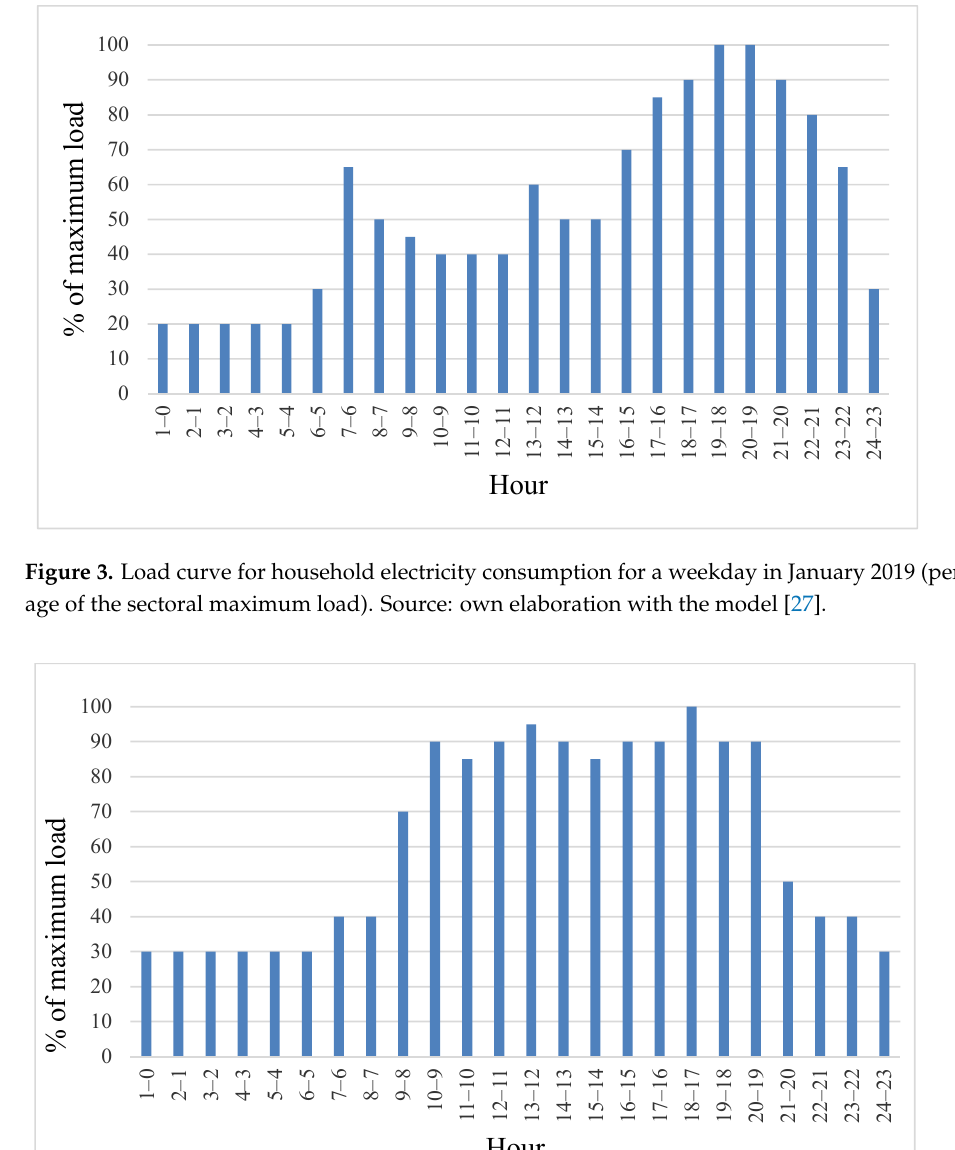
Figure 2. Calculation linkages between different modules in the LINDA model [20].